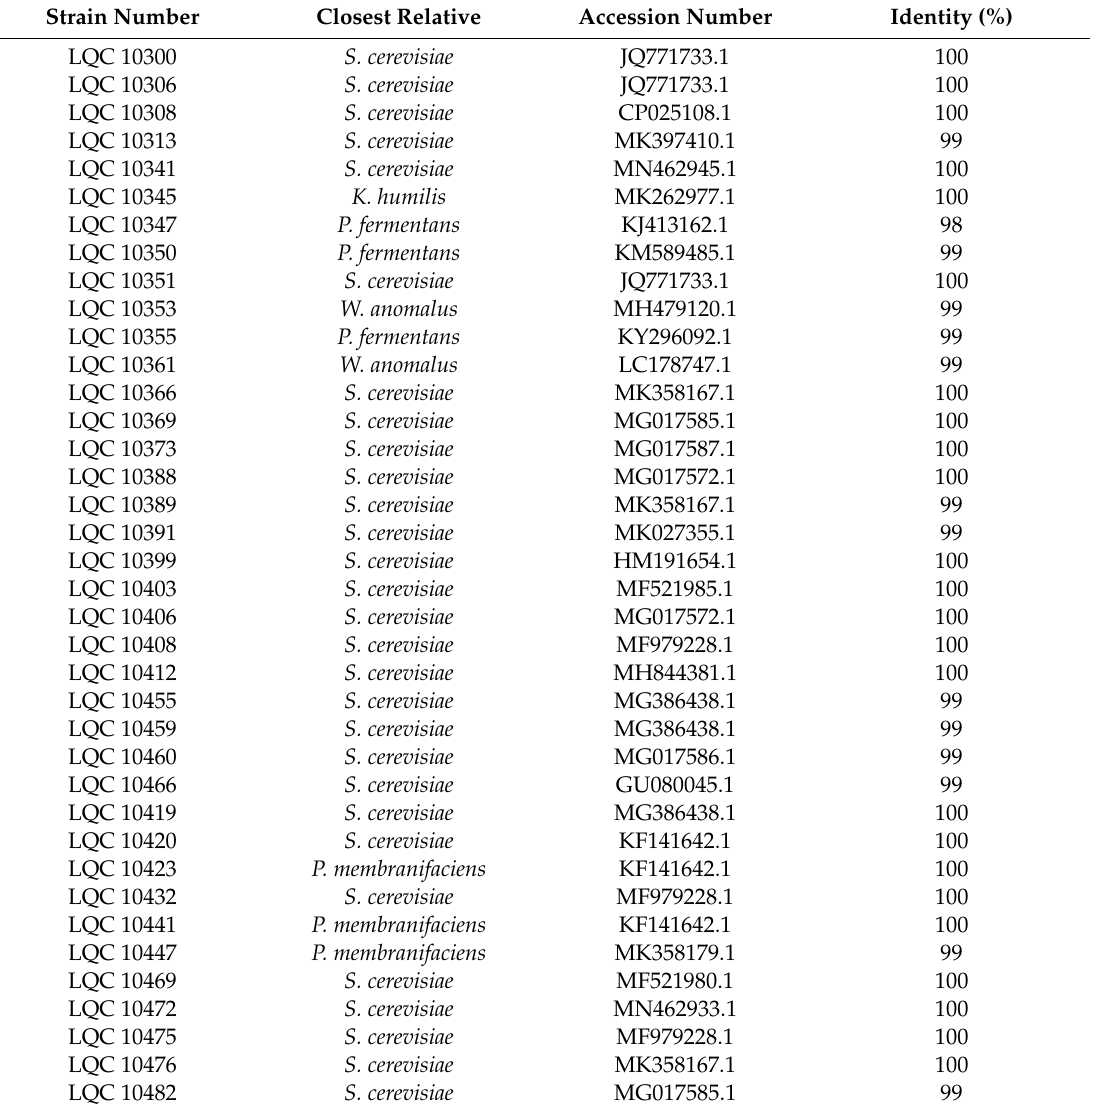
Table 4. Taxonomic a ffi liation of yeast strains based on sequencing of the D1 / D2 region of the 26S-rRNA